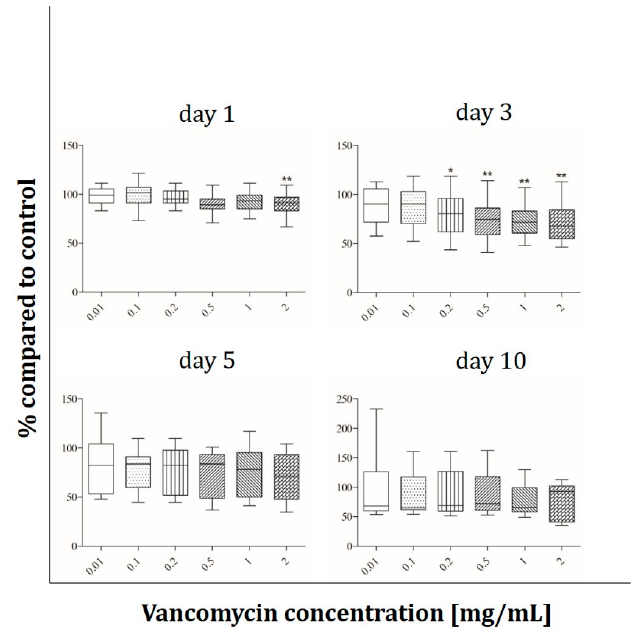
Figure 3. Proliferation of human osteoblasts after exposure to vancomycin for 1, 3, 5 and 10 days with change of antibiotic every 4 days (* p < 0.05; ** p < 0.01; *** p < 0.001 to control). The results are presented in percentage of the control without vancomycin (100%).